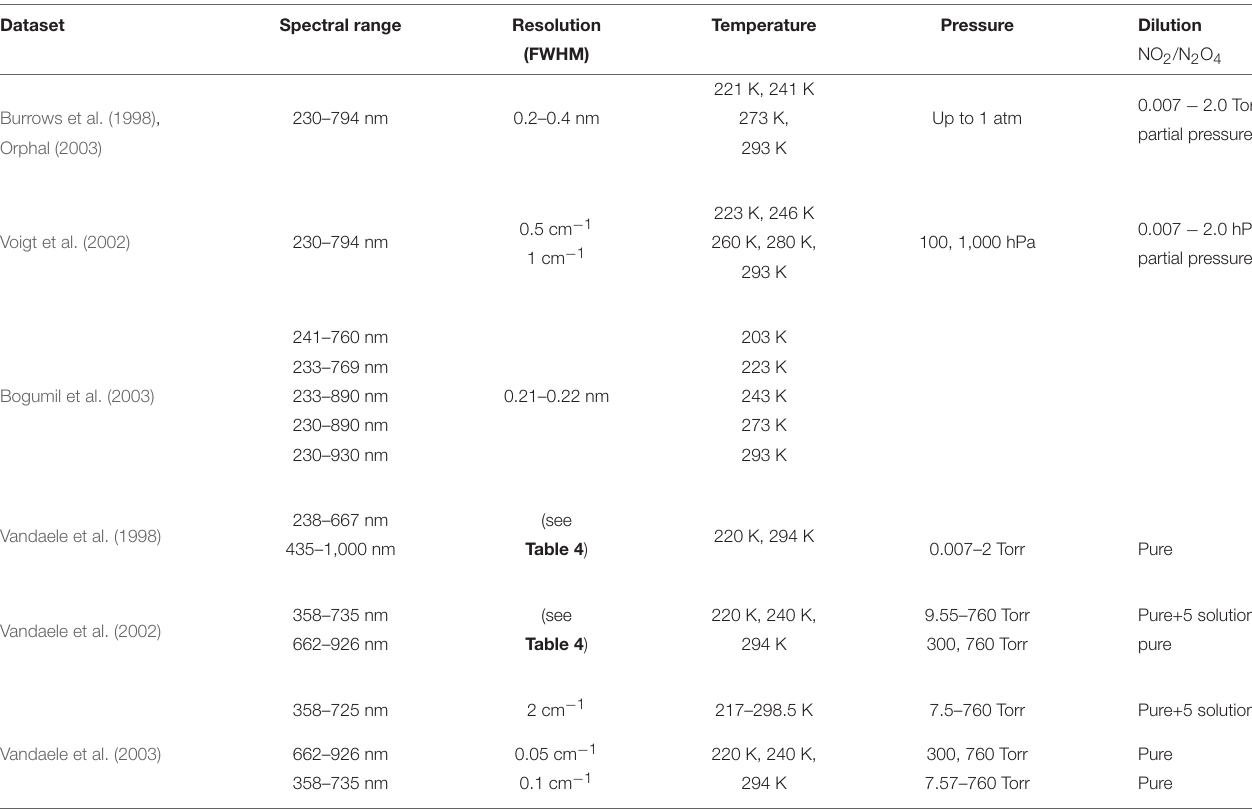
TABLE 3 | Datasets considered for the NO 2 absorption cross-section spectrum, and their characteristics. The datasets are restricted to the spectral range relevant for GOMOS.